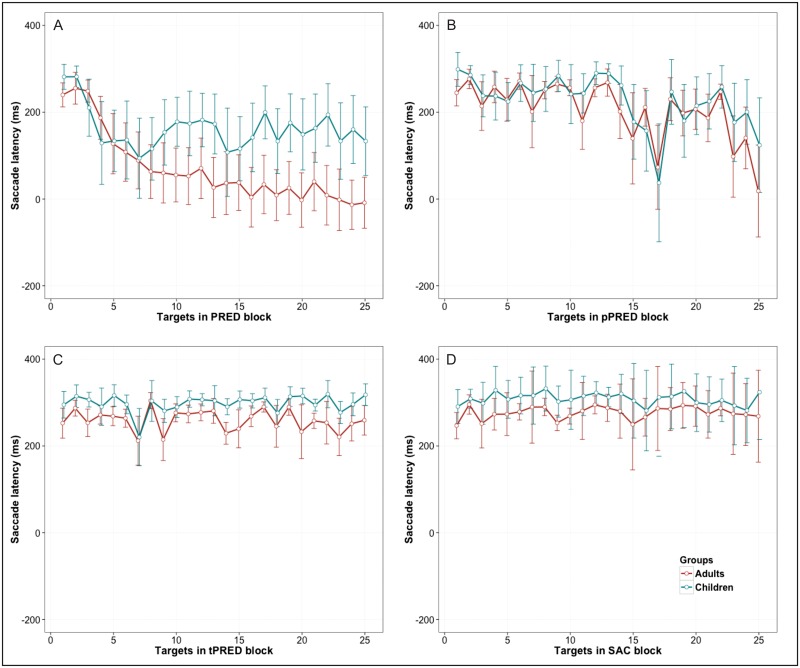
The saccadic latency along the task execution.Saccades latency for each stimuli within the block of tasks (A) PRED, (B) pPRED, (C) tPRED and (D) SAC. Median subjects’ latency for each stimuli along the task was averaged for within the group for children (red line) and adults (green line). Only in PRED task (A) saccadic latency reduced throughout the block near to 0 which indicates the learning of prediction in adults. The error bars depict the Standard Error.